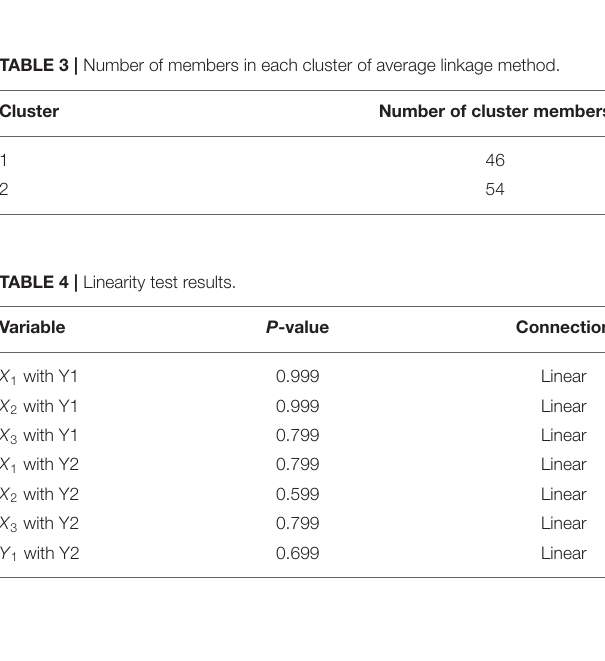
TABLE 6 | Result of homogeneity test of residual